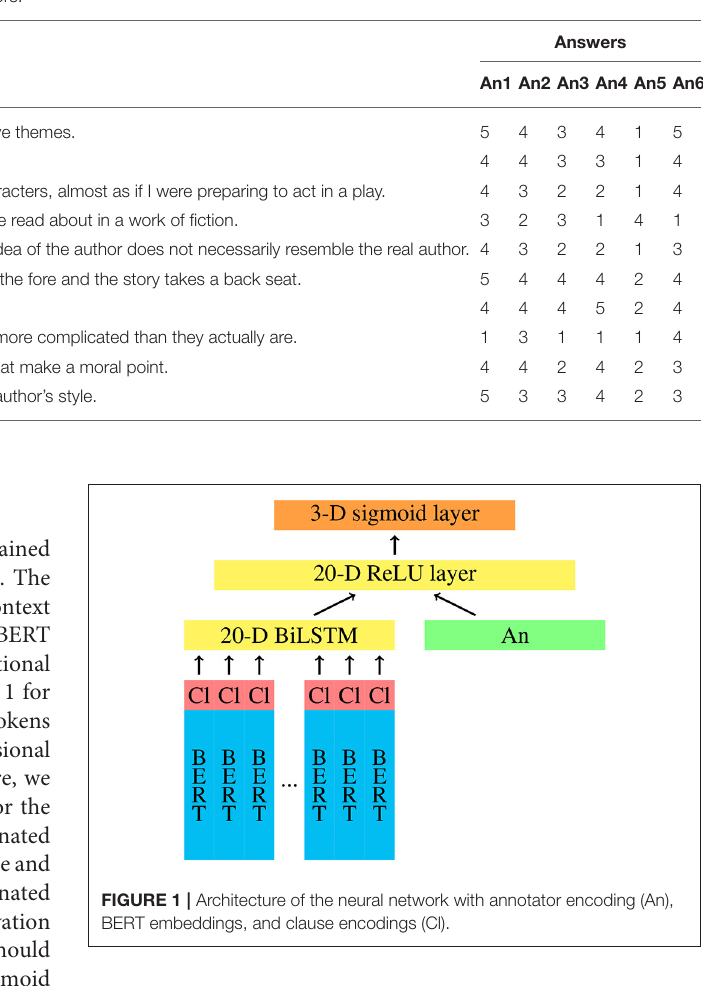
When training on unaggregated sets, no annotator encoding